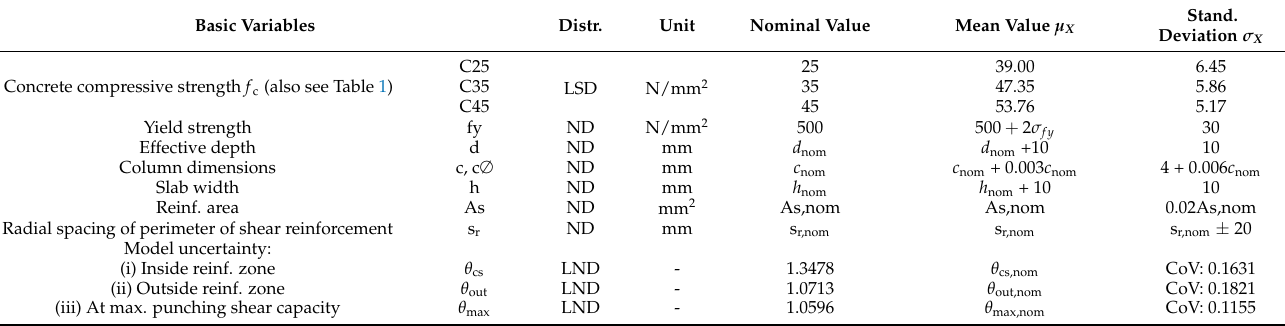
Table 3. Probabilistic models of the basic variables according to